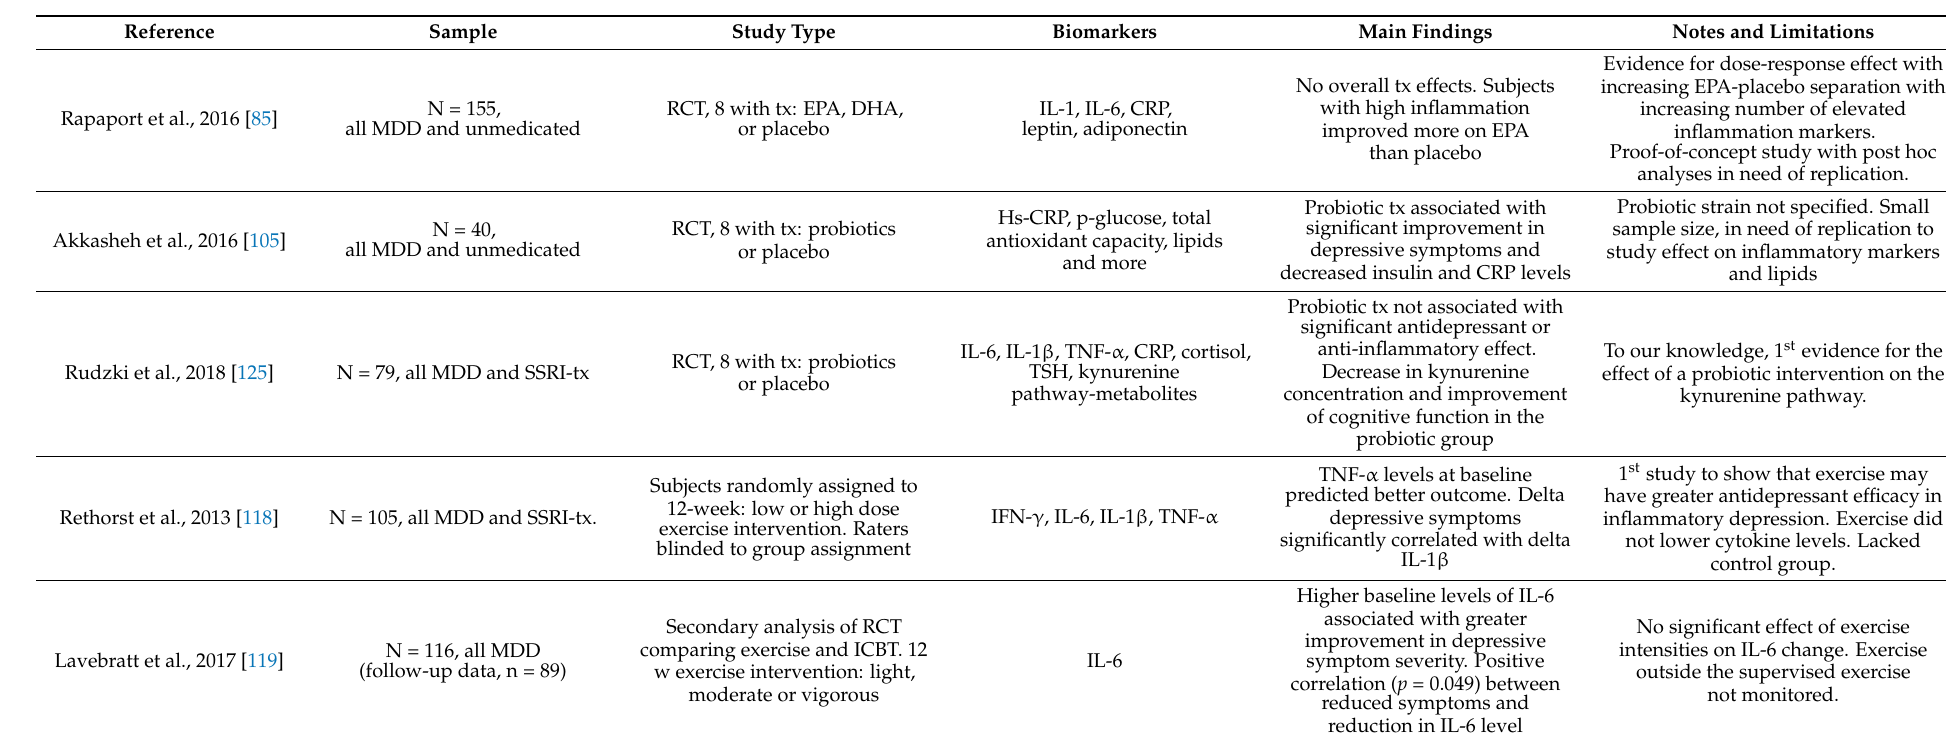
Table 1. Characteristics of key studies on treatment of inflammatory